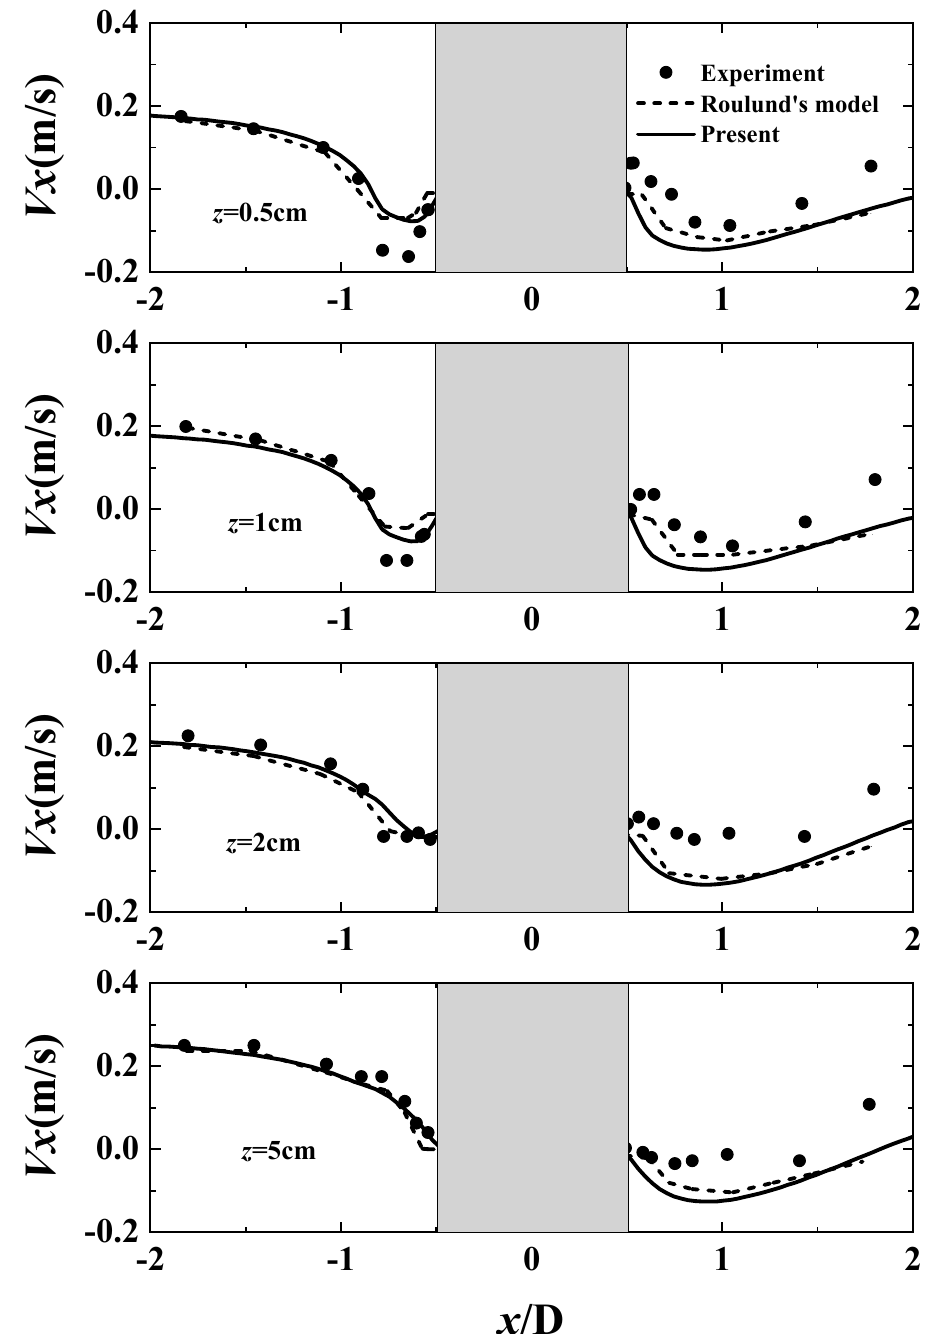
Figure 2. Distribution of horizontal velocity ( Vx ) in symmetry plane ( y = 0 m) at different distances from the bed.